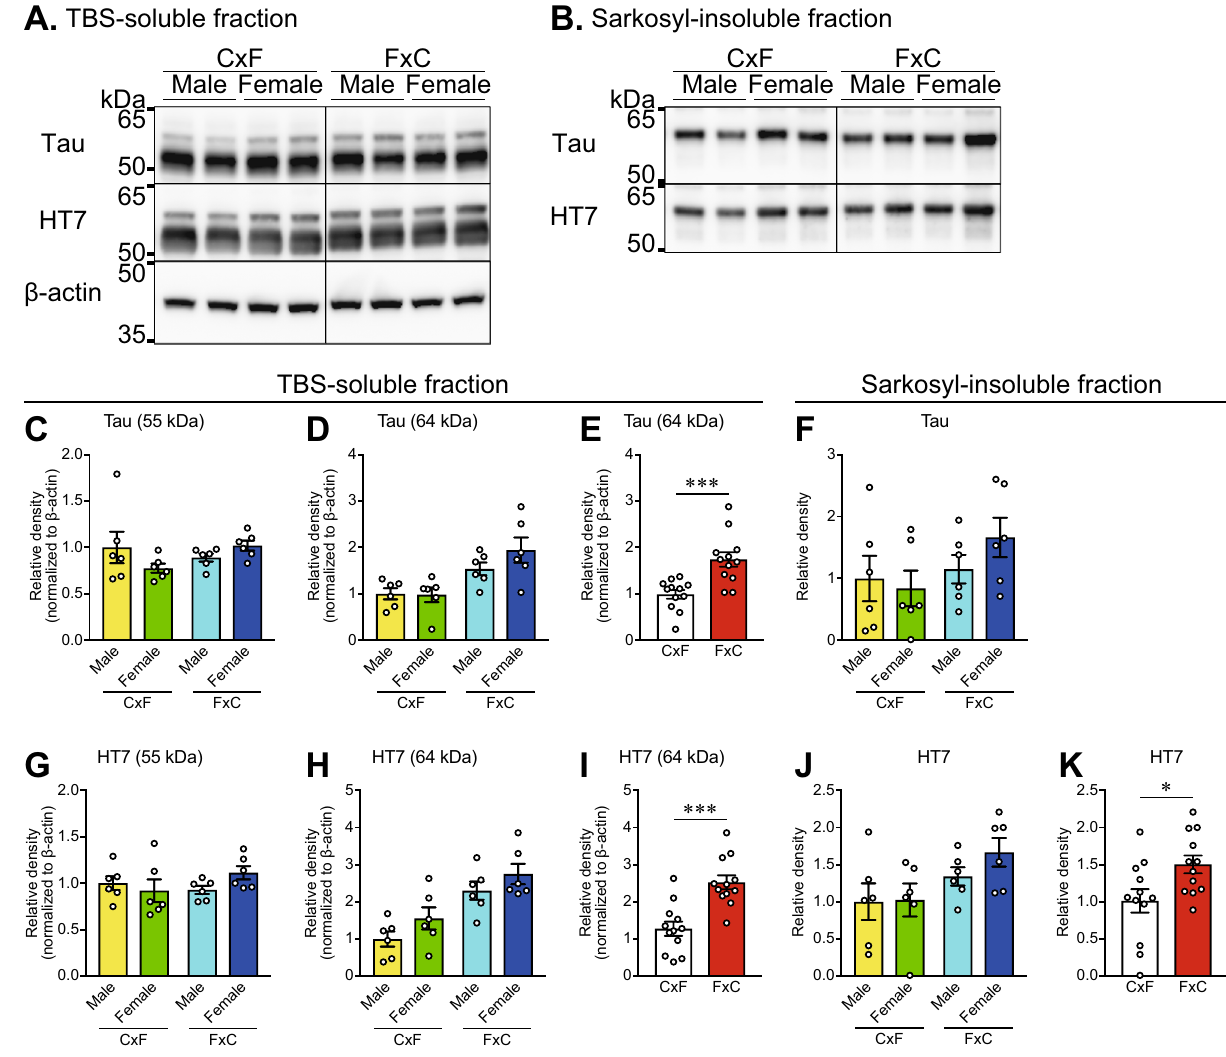
Figure 2. Accumulation of soluble and insoluble tau in rTg4510 mice at 6 months of age. ( A , B ) Representative images of western blots for Tau and HT7 in the TBS-soluble fraction ( A ) and sarkosyl-insoluble fraction ( B ) of the cerebral cortex. β-actin was used as a loading control. The band images in each row were obtained from the same gel with separation of the CxF and FxC samples. Full-length blots are presented in Supplementary Figure S11. ( C – K ) Densitometric analysis of tau accumulation. Two-way ANOVA (genetic background × sex) revealed a main effect of the genetic background, but no effect of sex, on levels of Tau ( D ) and HT7 ( H ) at 64 kDa in the TBS-soluble fraction and HT7 ( J ) in the sarkosyl-insoluble fraction (Supplementary Table S1). The Mann–Whitney U test revealed significantly higher levels of Tau ( E ) and HT7 ( I ) at 64 kDa in the TBS- soluble fraction and HT7 ( K ) in the sarkosyl-insoluble fraction from rTg4510_FxC mice, as compared with rTg4510_CxF mice. The rTg4510_CxF and rTg4510_FxC groups contained six males and six females each (n = 12/group). Data are presented as the mean ± SEM. *** p < 0.001, * p < 0.05 (Mann–Whitney U